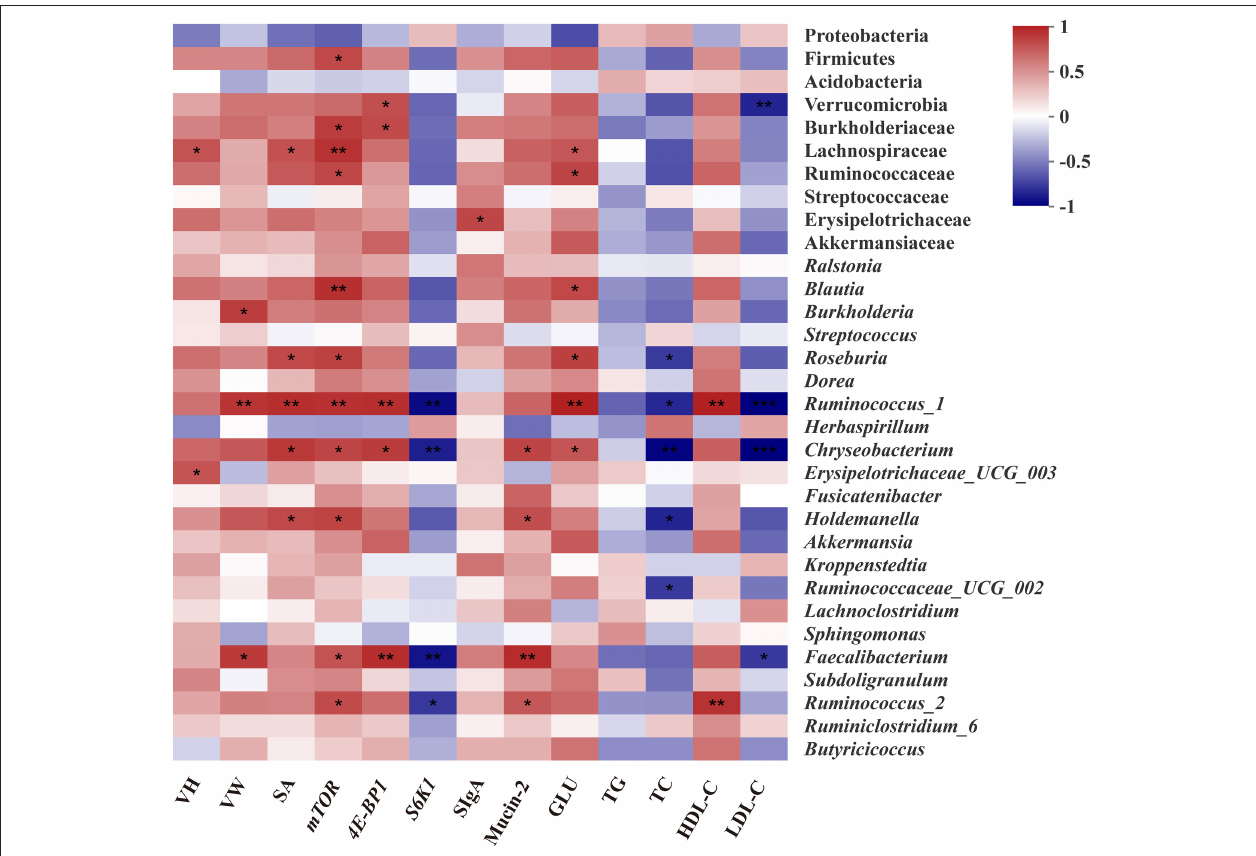
FIGURE 7 | Spearman’s correlation analysis between the abundances of intestinal microbiota and intestinal or serum biochemical parameters. Red represents a positive correlation and blue represents a negative correlation. Significant correlations are noted by.01 < p ≤ 0.05*, 0.001 < p ≤ 0.01**, p ≤ 0.001***. VH, Villus height; VW, Villus width; SA, Surface area; SIgA, Secretory Immunoglobulin A; GLU, Glucose; TG, Triglycerides; TC, Total cholesterol; HDL-C, High-density lipoprotein cholesterol; LDL-C, Low-density lipoprotein